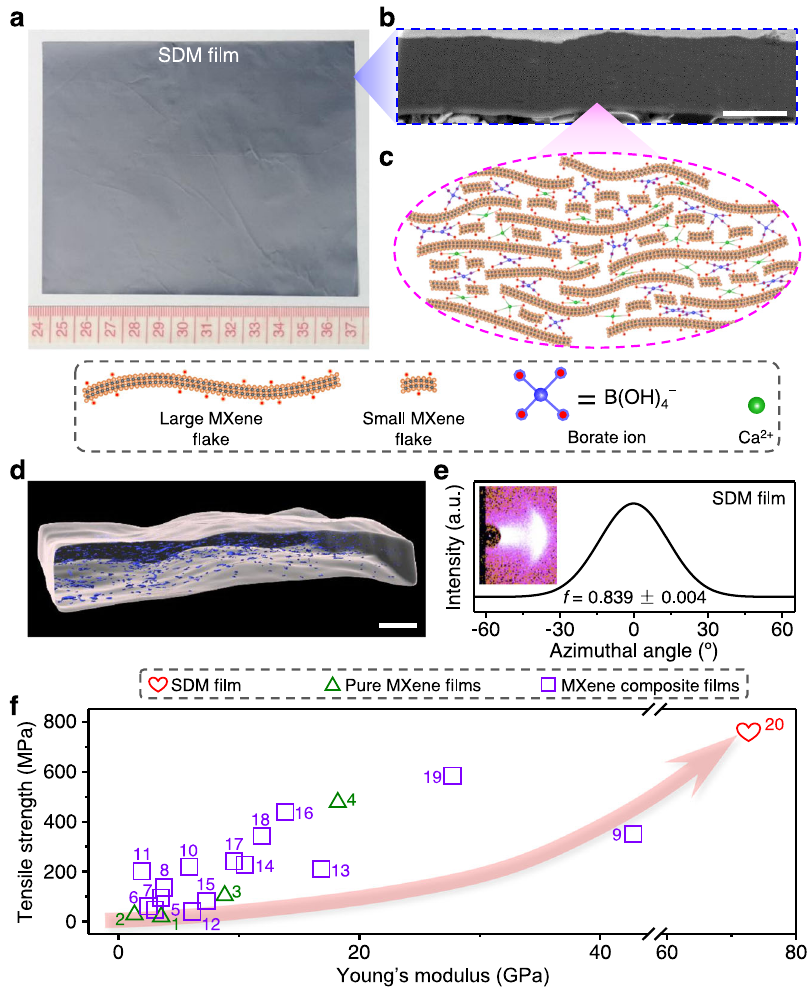
Fig. 1 | Structural characterizationand mechanicalperformance ofSDM fi